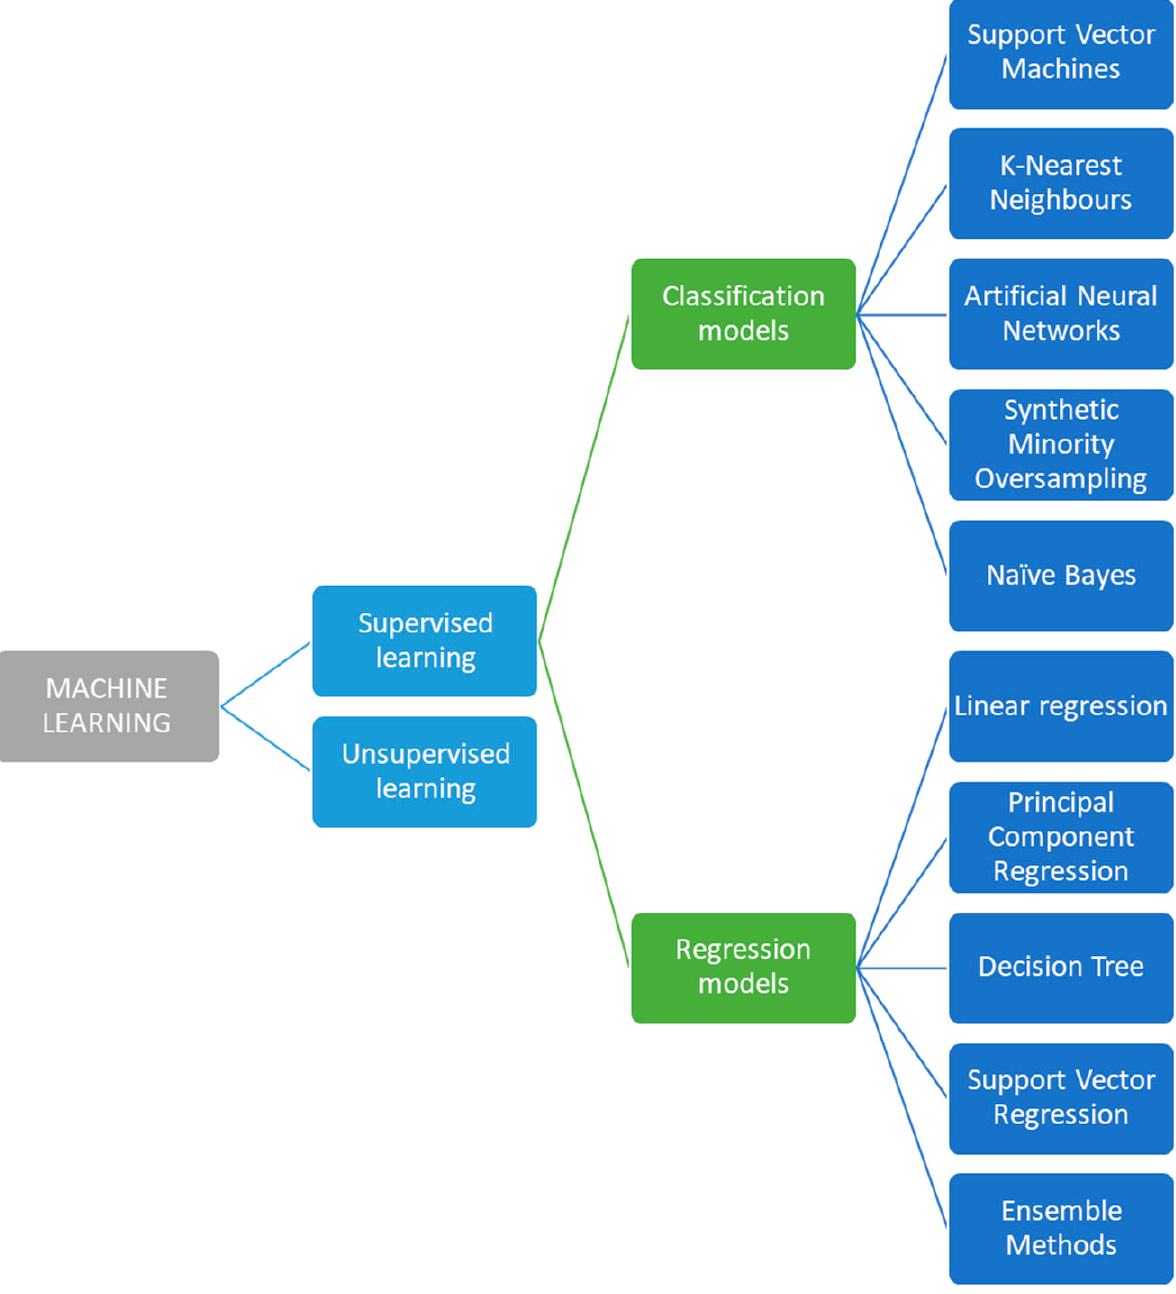
Figure 13. Classification of ML algorithms. Ensemble methods combine two or more models. Examples of ensemble methods are random forest and gradient boosting.